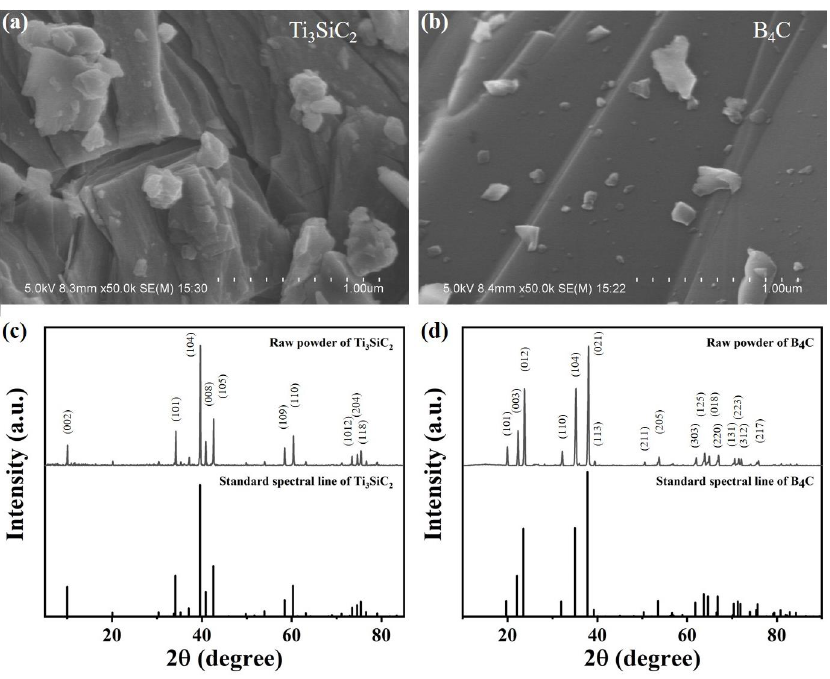
Figure 1. ( a ) SEM image of Ti 3 SiC 2 ; ( b ) SEM image of B 4 C; ( c ) XRD pattern Ti 3 SiC 2 ; ( d ) XRD pattern of B 4 C.